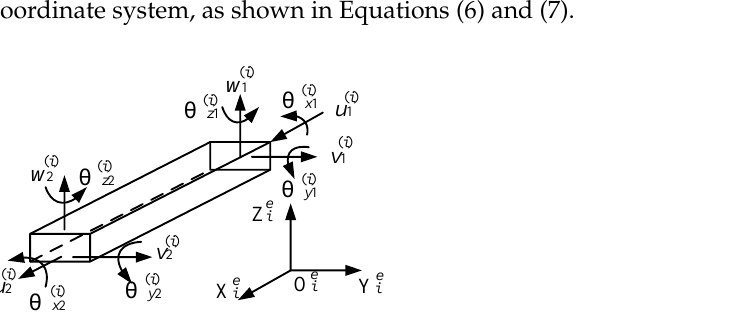
Figure 5. Model of HDVMC based on spatial beam element. ( a ) Element node information and co- ordinate system definition. ( b ) Force analysis under gravity.